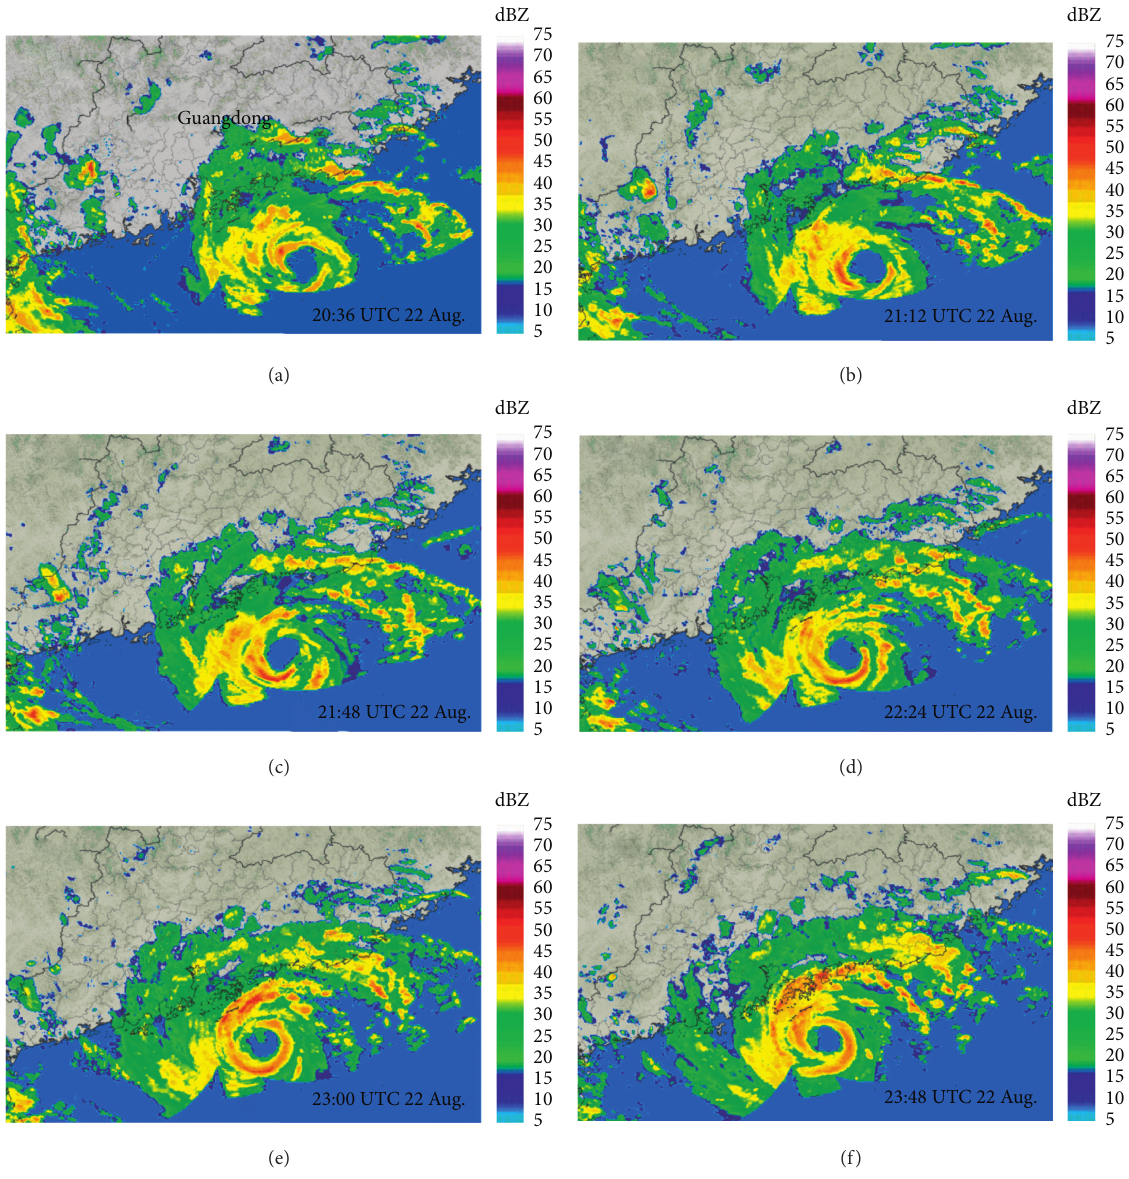
Figure 1: Radar composite reflectivity at 3km altitude (unit: dBZ) from China Meteorological Administration (CMA) operational weather radars in Guangdong Province on 22 August 2017: (a) 20:36 UTC, (b) 21:12 UTC, (c) 21:48 UTC, (d) 22:24 UTC, (e) 23:00 UTC, and (f) 23: 48